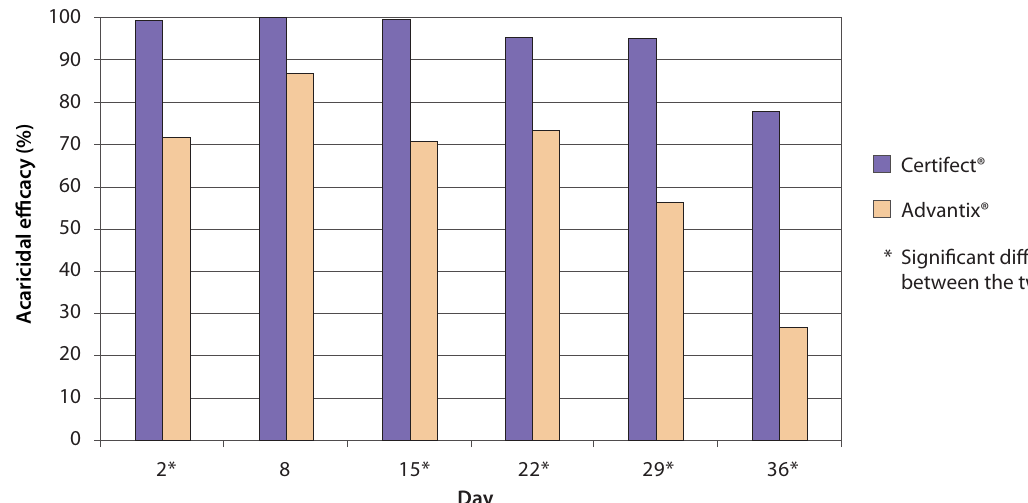
Fig 2. – Comparative acaricidal efficacy at 24-hour tick